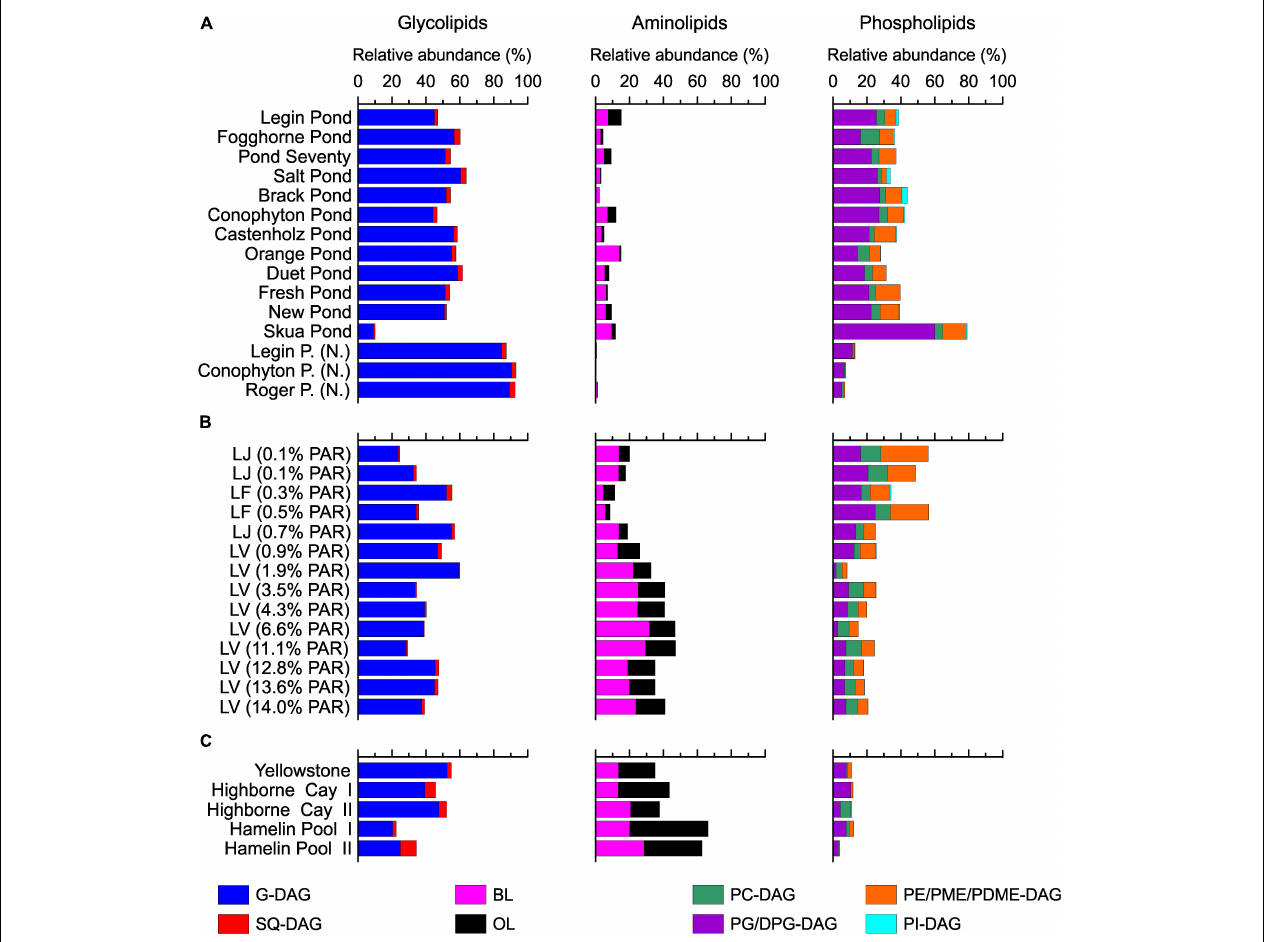
FIGURE 5 | Intact polar lipids head group distribution in the meltwater ponds from the McMurdo Ice Shelf (A) . Samples with (N.) indicate ‘Nostoc spheres’, which were collected in three different meltwater ponds. Panel (B) shows the results from the three different Antarctic lakes: Lake Joyce (LJ), Lake Fryxell (LF), and Lake Vanda (LV). The brackets show the percentage of photosynthetically active radiation (PAR) that reached the microbial mats. The PAR was adopted from previous studies (Jungblut et al., 2016; Mackey et al., 2017b, 2018; Matys et al., 2019). Panel (C) shows the relative abundance of IPLs in the microbial mats from the Yellowstone National Park (United States), Highborne Cay (Bahamas), and Hamelin Pool